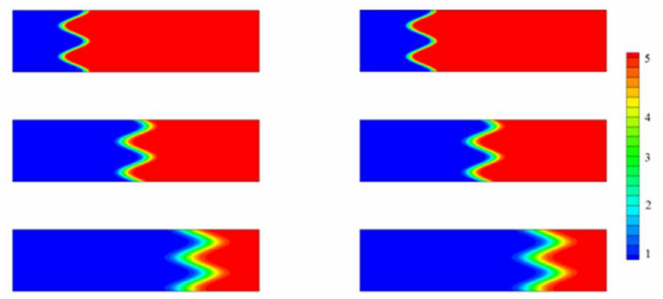
Figure 2. Two-dimensional (2-D) manufactured solutions of density at different times (top: t = 0.0, middle: t = 0.5, and bottom: t = 1.0), left: analytical solution, right: numerical results of the